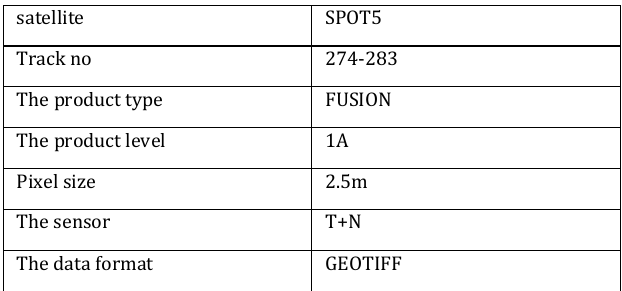
Table 1: Main parameters of remote sensing images satellite